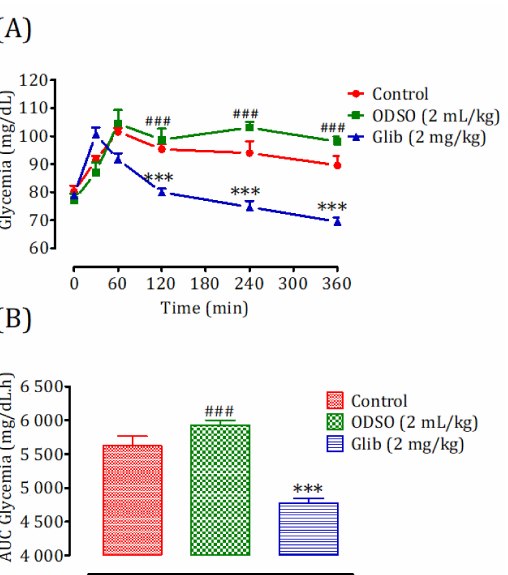
curve of the distilled water-treated rats (8098 ± 806 mg/dL/h). Moreover, there was not a significant difference between the area under the curves of the ODSO and glib groups (Figure 2B).